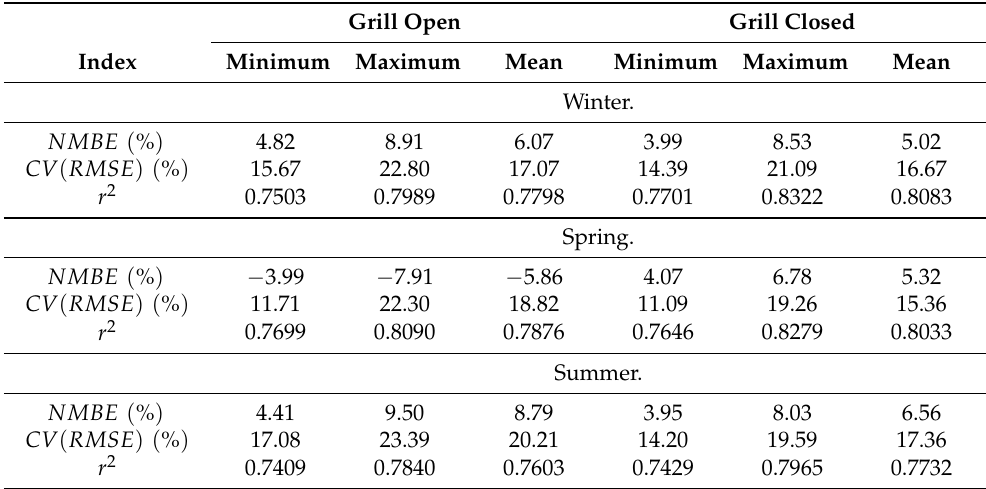
Table 7. Values of the statistical indicators for air velocity. Grill Open Grill